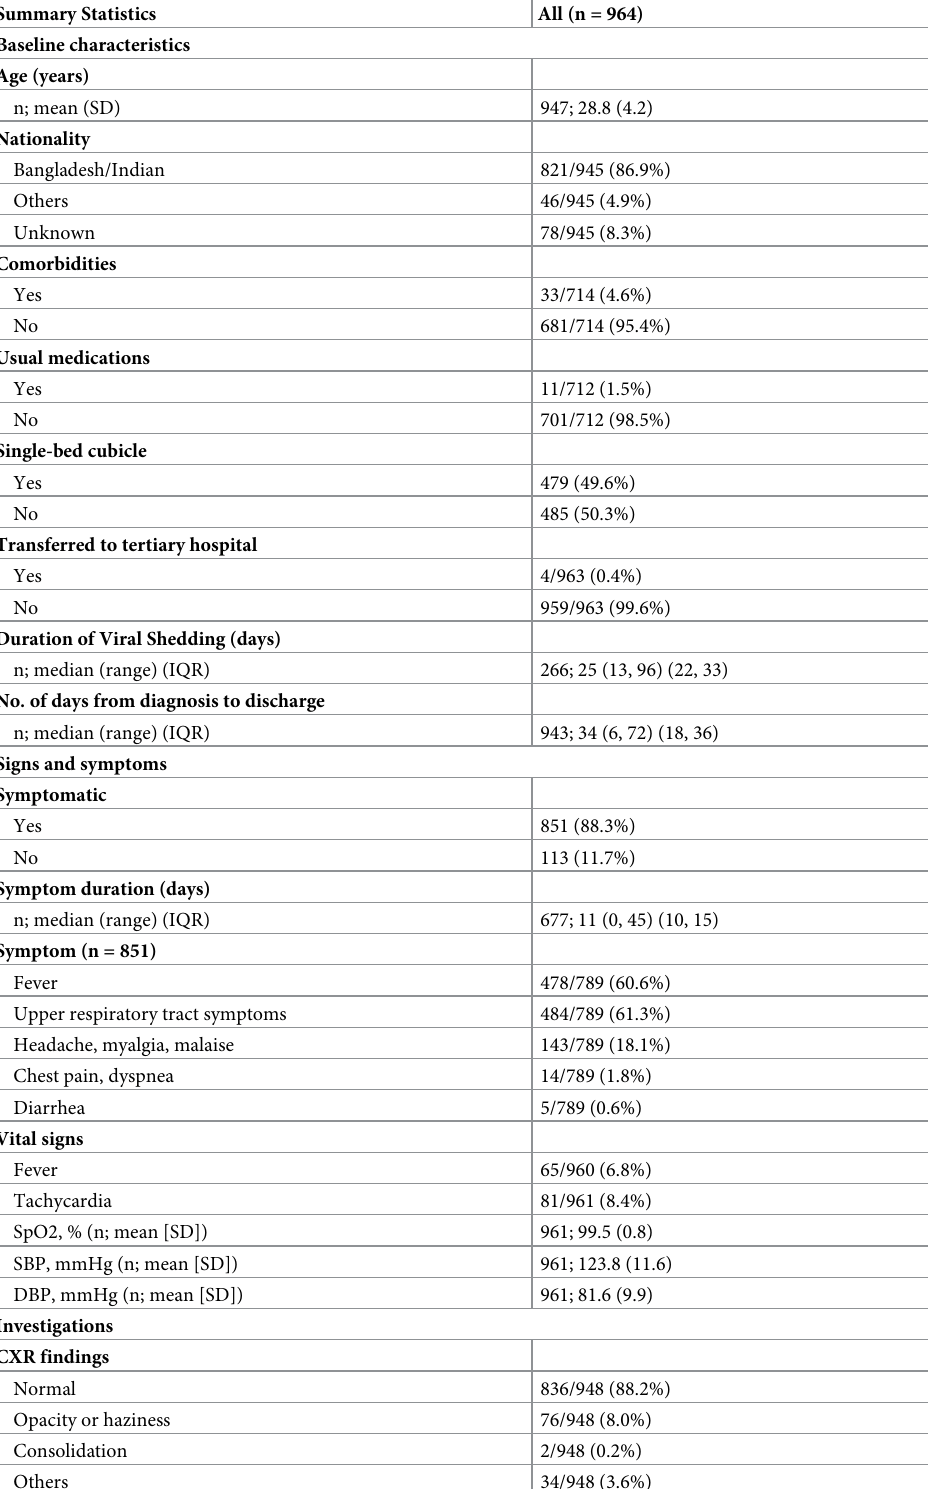
Table 1. Baseline characteristics, signs and symptoms, investigations of all